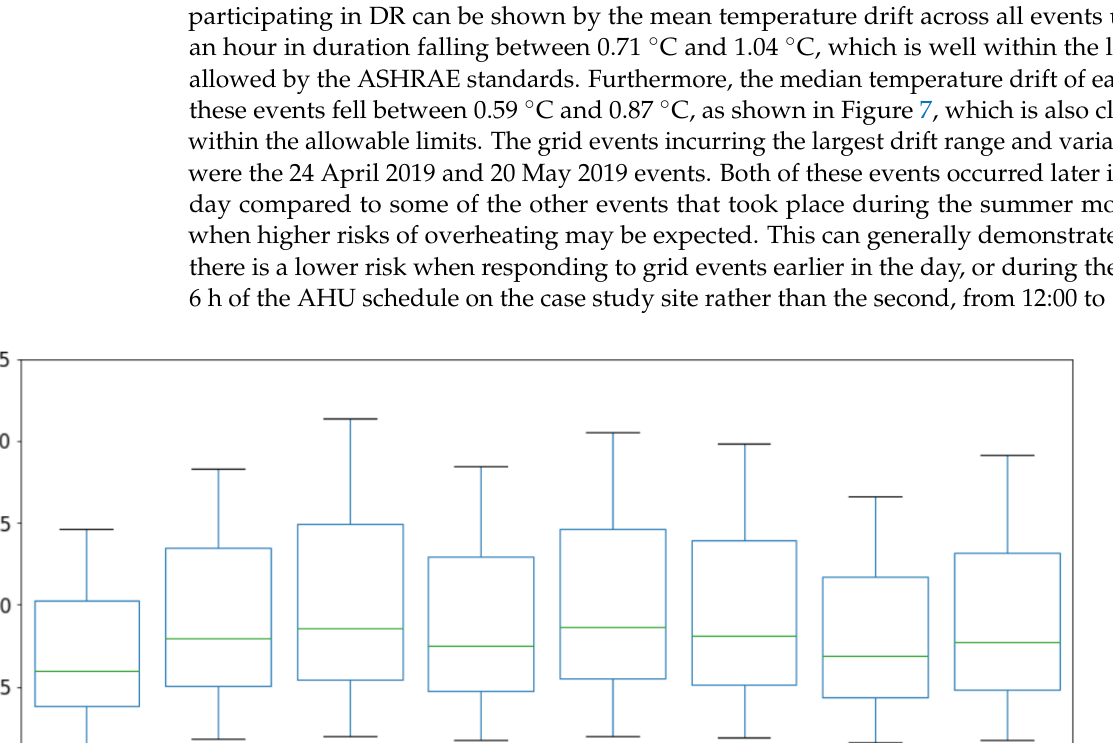
Figure 7. Box-and-whisker plot of indoor air temperature drift for all durations on each grid frequency event day, with median represented by an internal green horizontal line.